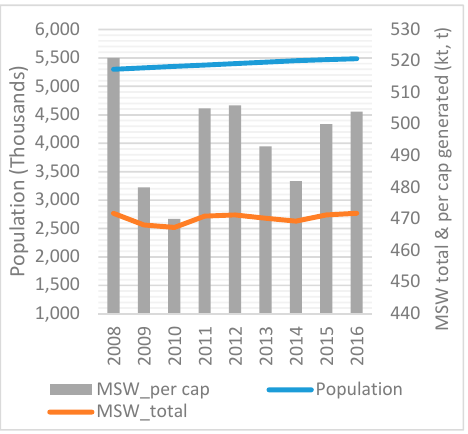
Figure 51. Population and MSW production in Finland 2008–2017 (EUROSTAT 2019a, 2019c).